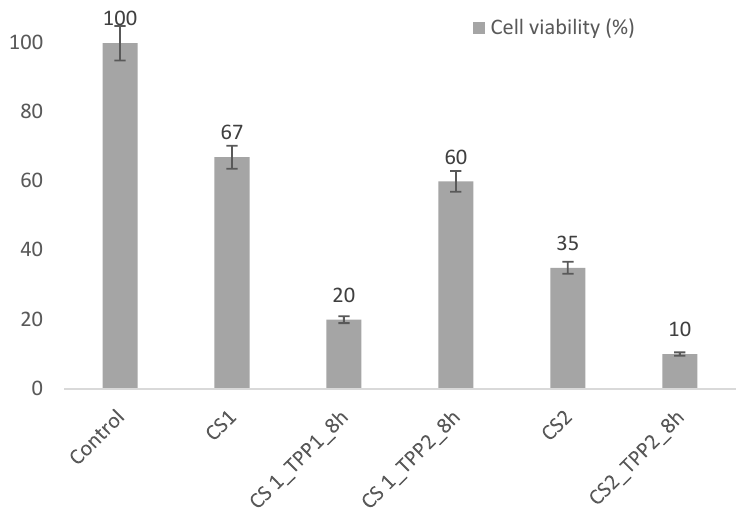
Figure 9. Cell viability (CV) of osteoblasts seeded on selected samples.